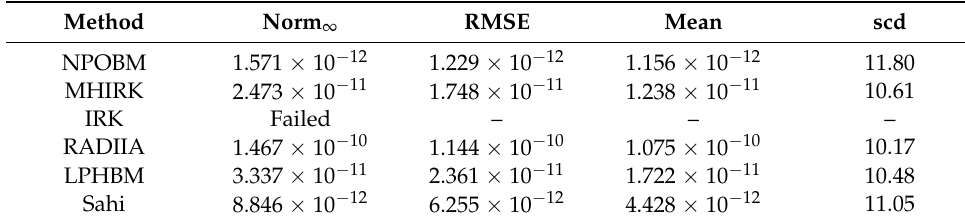
Table 19. Numerical results for Problem 5 with NS = 2 8 where x ∈ [ 0,20 ] .